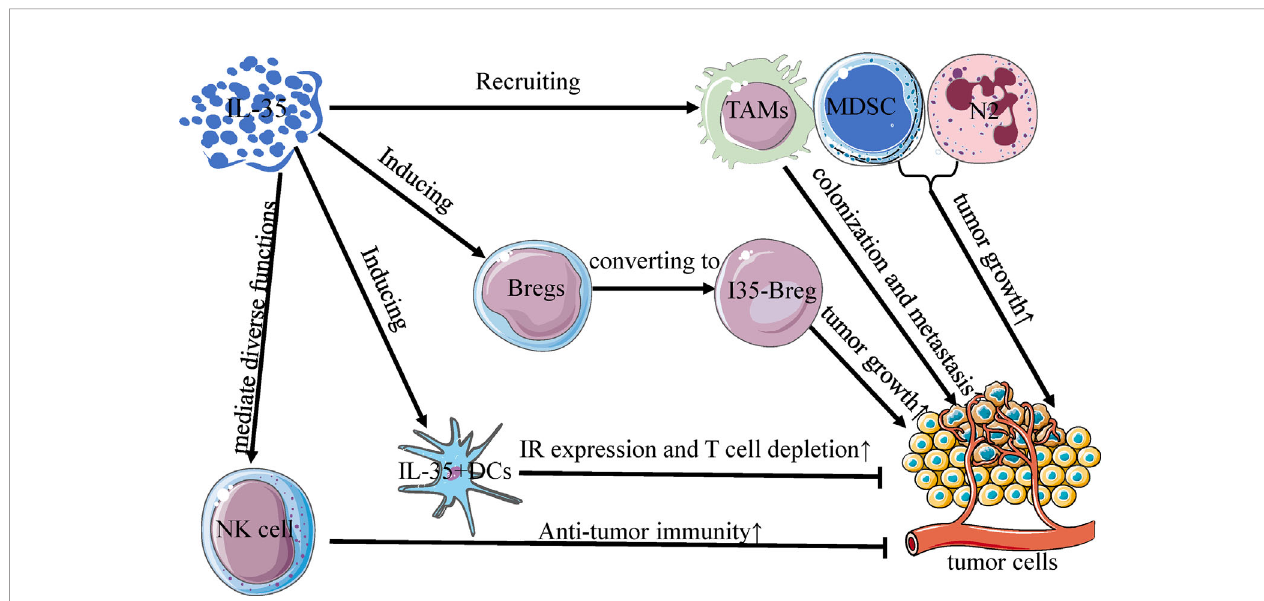
FIGURE 2 | Interactions between IL-35 and other immune cells in TME. IL-35 regulates the activity of immune cells in the tumor microenvironment, and is mainly produced by Bregs, DCs, NK cells, TAMs, MDSC, and N2 neutrophils. Much like the differentiation of Treg cells, IL-35 can convert Bregs to an active subset (I35- Bregs) which secrete IL-35 to promote tumor growth. With increased inhibitory receptor expression and T cell depletion, IL-35 + DCs can slow primary tumor growth rates, unlike other IL-35 + immune cells. Furthermore, IL-35 mediates diverse functions in NK cells and is obligatory for promoting the early NK cell-mediated responses to enhance primary anti-tumor immunity. TAMs, MDSCs, and N2 cells recruited by IL-35 can similarly potentiate primary tumor growth and metastatic colonization in the tumor